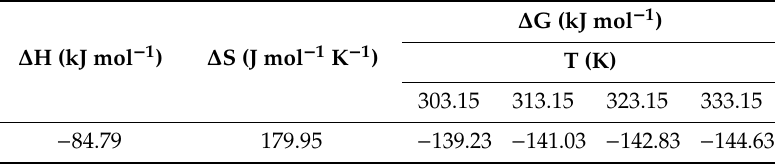
Table 2. Thermodynamic parameters for RO16 adsorption by MA-AC400.